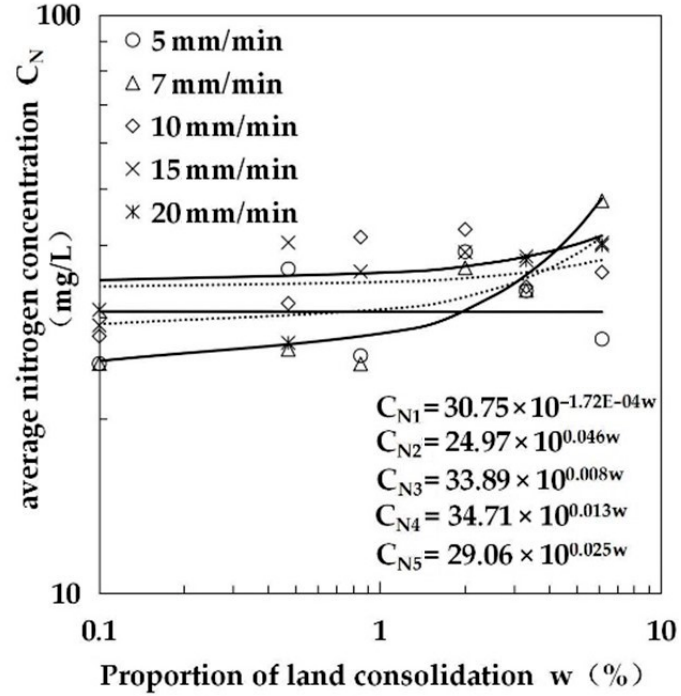
Figure 29. Changes in average nitrogen concentration at the outlet with land consolidation proportion under different rainfall intensities.